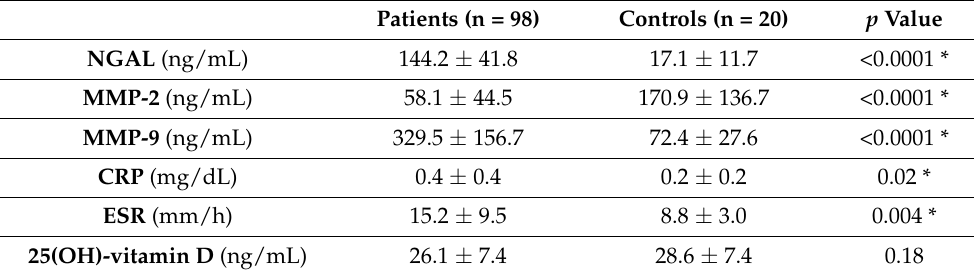
Table 2. Laboratory data of patients with psoriasis and healthy controls.